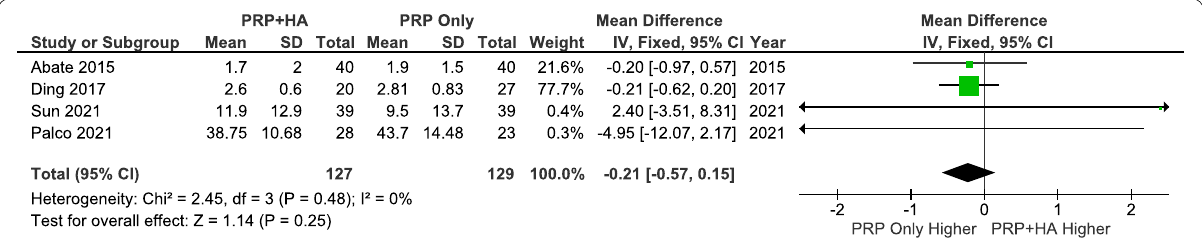
Fig. 6 Showing the Forest plot comparing the VAS scores between PRP